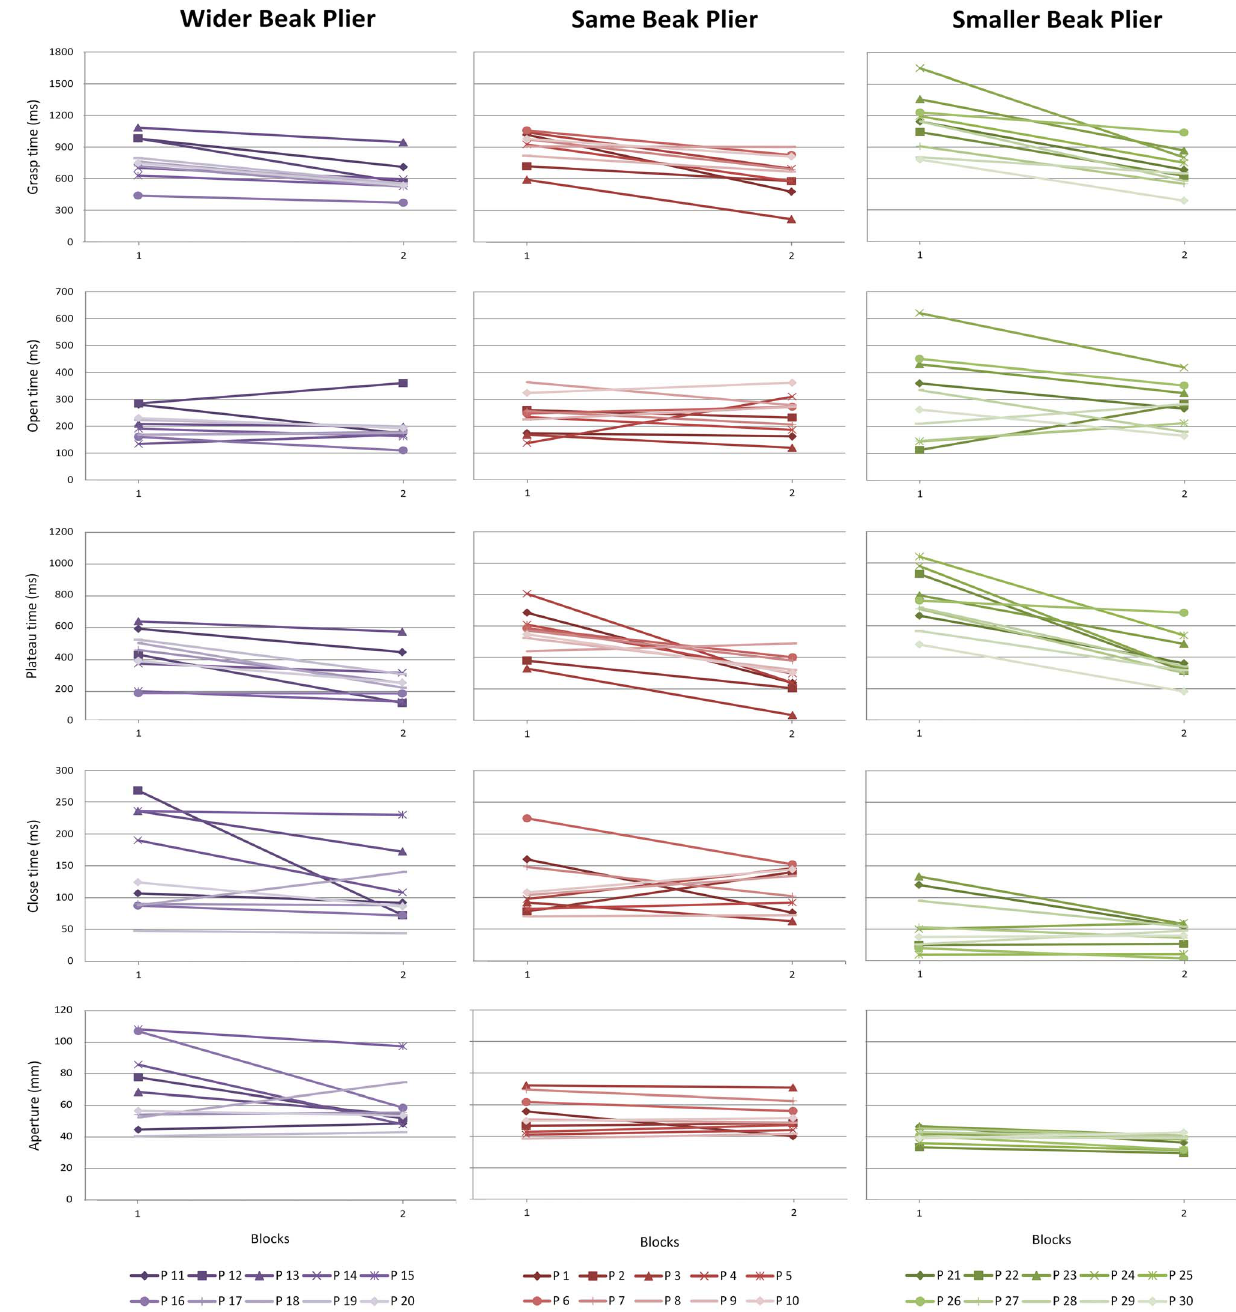
Figure 5. Individual changes in learning paths over the first trials of practice day 1. Changes over practice trials in hand opening, plateau phase, hand closing, and in aperture for all participants (10 participants in total for each pair of pliers) shown for block 1 (trial 1–5) and for block 2 (trials 51–55).